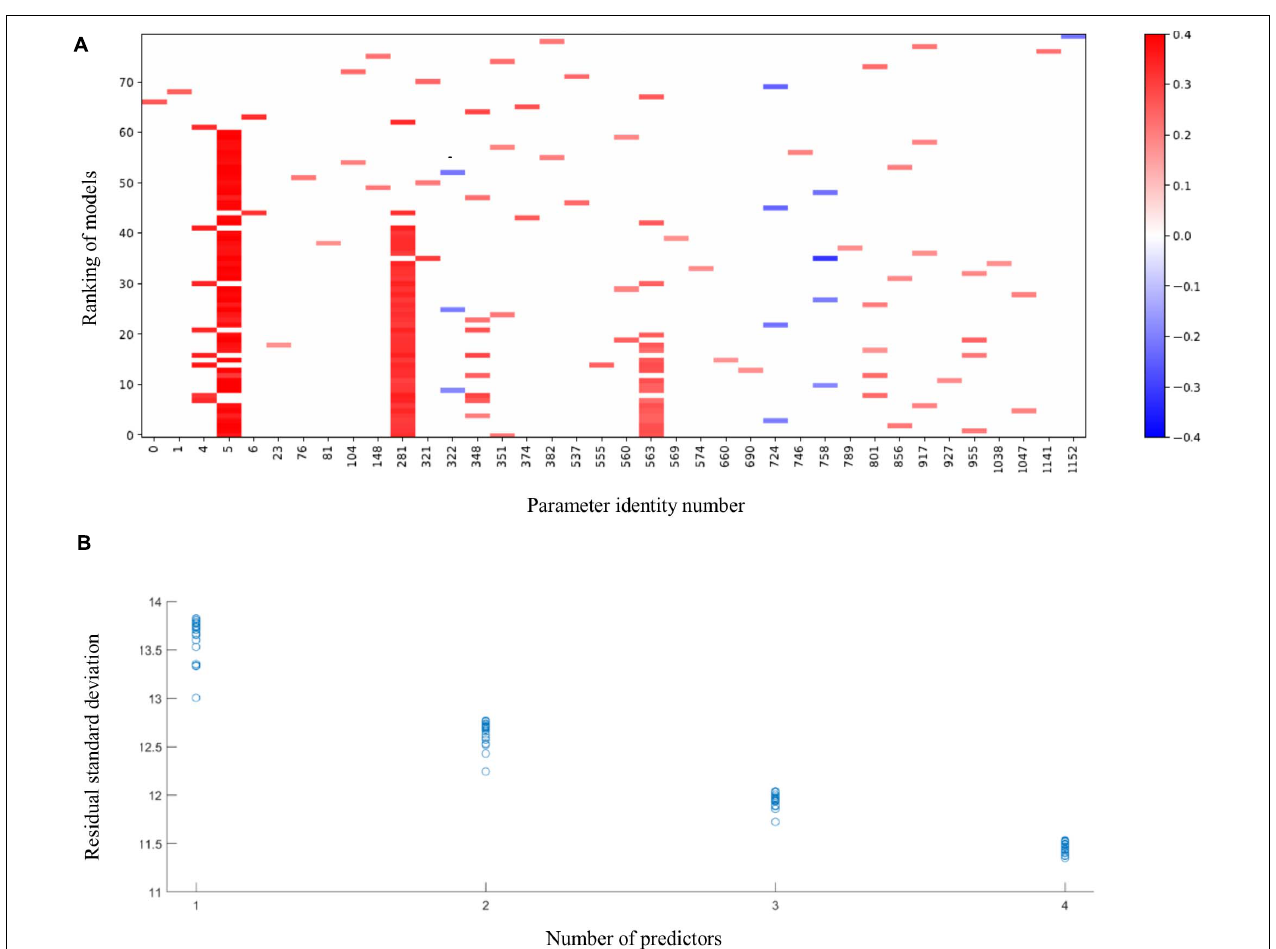
FIGURE 1 | The 20 best fitting models of 1 up to 4 terms linking language development of children aged 36 months to membership of the intervention or control group, values of 6 developmental parameters of the same children when aged 20–24 months, their microbiota composition at that age, and microbiota composition at 36 months. (A) Predictors in the models. Language development and all predictors are normalized to a mean of 0 and a standard deviation of 1. Horizontal labels correspond with the predictors’ identification number in the data file. The parameters include the following scores at 24 months: the intervention indicator (0); height to age, HAZ (1); weight to age, WAZ (2); weight to height, WHZ (3); cognition (4); language development (5); motoric development (6). These are followed by the gut microbiota parameters at 24 months (parameters 7–548) and at 36 months (parameters 548–1169). Vertical coordinates 1–20, 21–40, 41–60, and 61–80 show best fitting models with 4, 3, 2, and 1 terms, respectively. Blue pixels correspond with negative coefficients and red pixels correspond with positive coefficients. Intensity of the pixels increases with size of the model coefficients. (B) Residual standard deviations plotted against the number of terms in the models for language development; language development in original units.